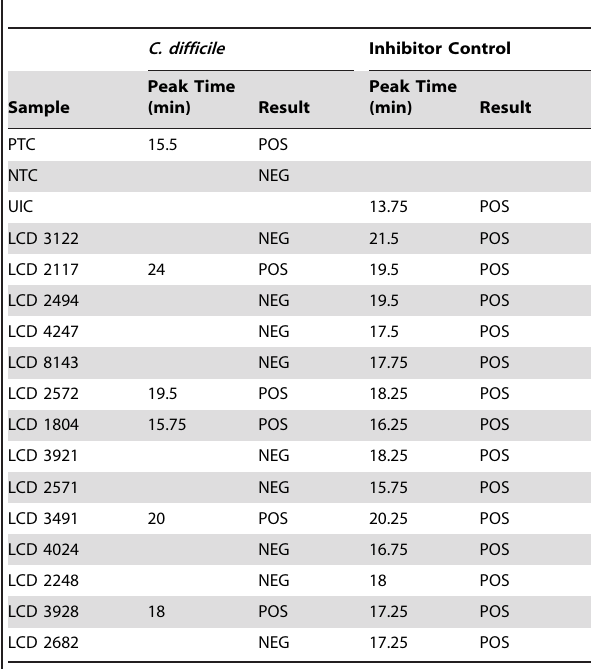
Table 2. Example C. difficile HE-LAMP-BART